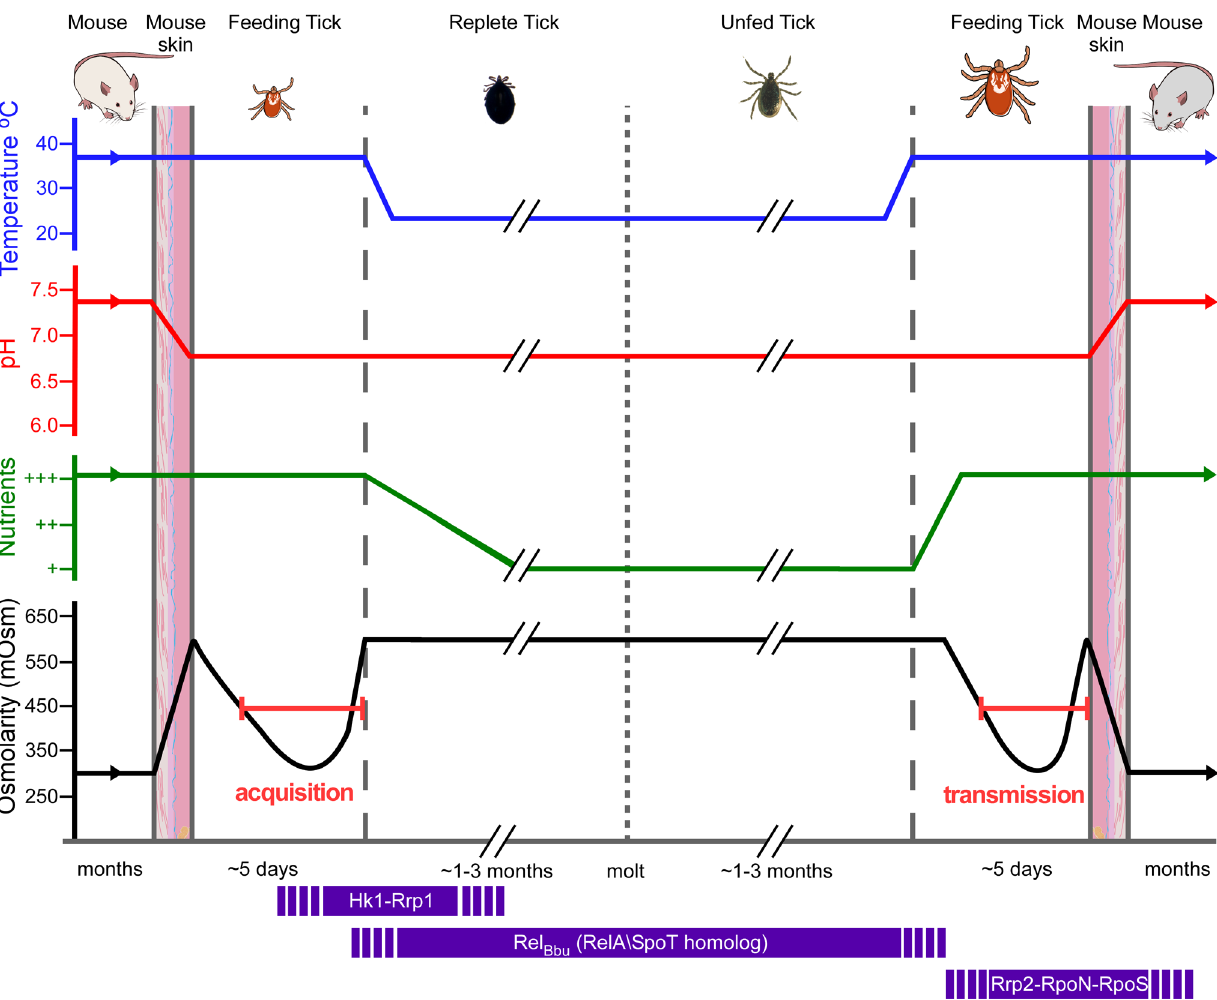
Fig 9. Model for generation of osmotic stress and its effect on regulatory pathway during the enzootic cycle. During acquisition, spirochetes encounter an increase of the osmolarity, which requires gene regulation by Hk1-Rrp1. The activation of Hk1-Rrp1 system increases the level of c-di-GMP which triggers metabolic adaptation to the new environment and also affects cell motility [7, 37, 62]. After feeding, the depletion of nutrients activates Rel Bbu -dependent gene expression which promotes long-term survival in the midgut [3]. During the second feeding, Rel Bbu regulatory effects decrease, restoring normal growth in a nutrient replenished environment. Other relevant physiological changes (decreasing osmolarity, increased temperature, etc.) stimulate Rrp2-RpoN-RpoS-dependent virulence factors required for the transmission and successful colonization of a new